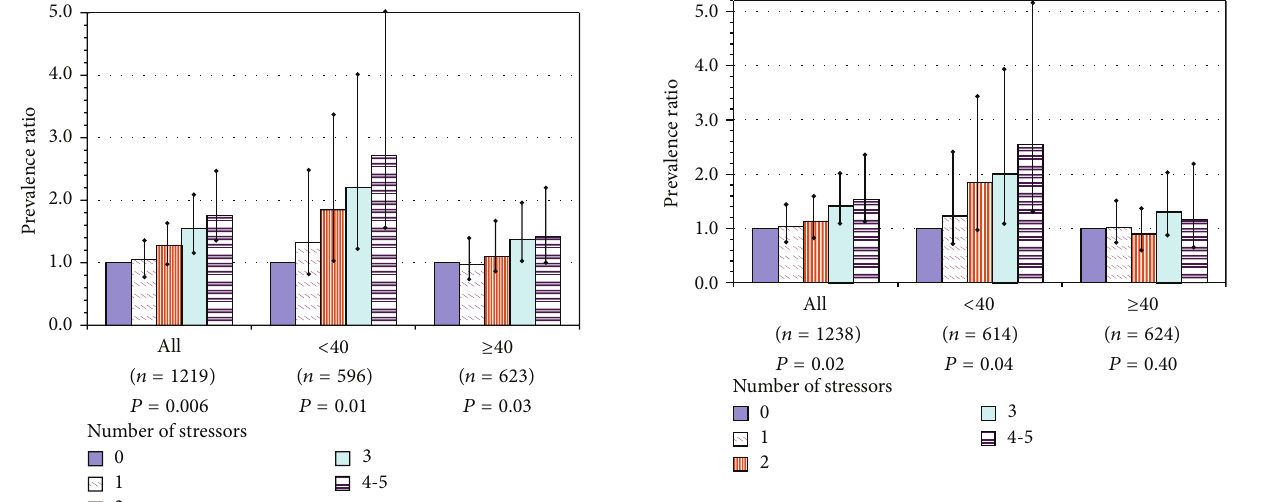
Figure 2: Current smoking among U.S. nursing home employees, as a function of number of workplace stressors in the current job, for all participants and by age group: prevalence ratios with 95% confidence intervals for each level above 0 stressors and 𝑃 value for test of linear trend. Index = sum of workplace stressors: low decision latitude, low supervisor support, recent assault(s) at work, having another paid job, and physically demanding work. Models adjusted for gender, education, and region; adjusted for age only in model of all workers.